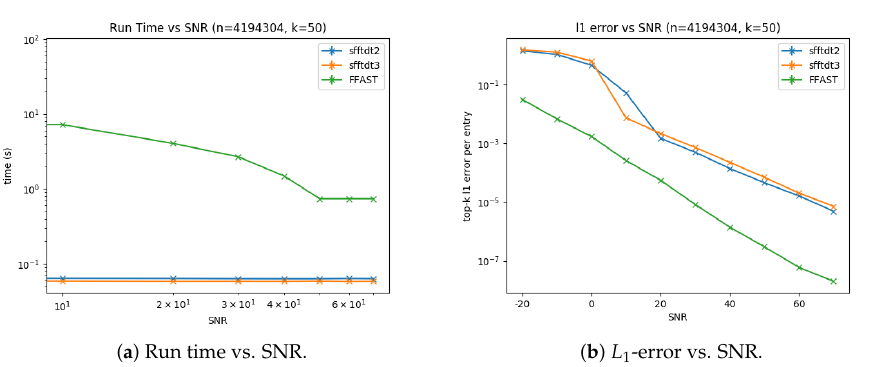
Figure 9. Run time and L 1 -error of three algorithms using the aliasing filter, including the sFFT-DT2.0, sFFT-DT3.0, and R-FFAST algorithms in the general sparse case vs.